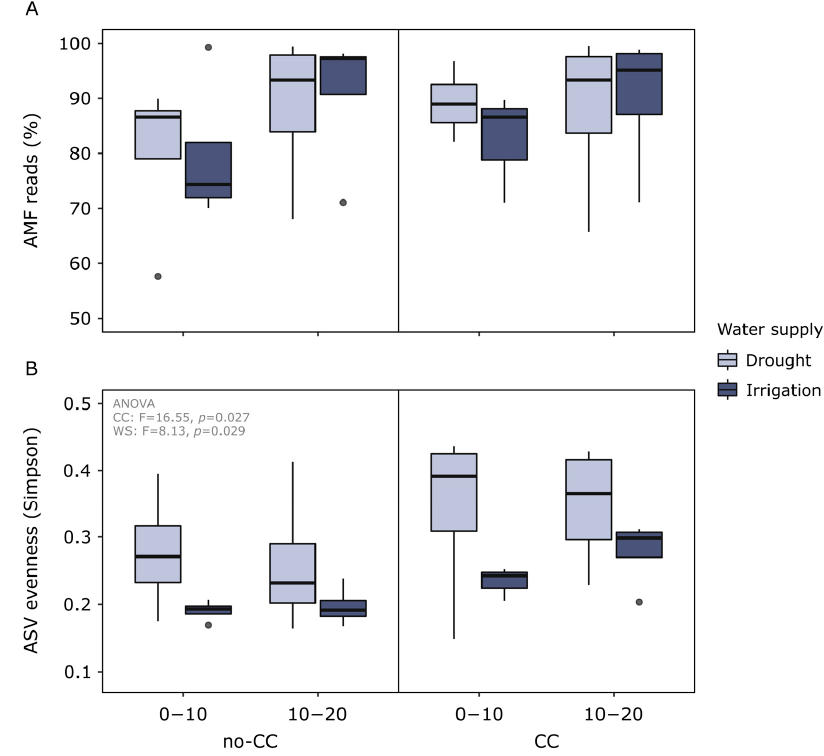
Figure 2. Percentage of arbuscular mycorrhizal fungi (AMF) reads out of the total sequenced reads ( A ) and amplicon sequence variant (ASV) Simpson evenness of soil AMF communities ( B ) in response to cover crops (CC) (no-CC: no cover crop; CC: 4-species cover crop) and water supply (WS) (drought; irrigation). Data are shown for two different soil depths (0–10 and 10–20 cm). Boxplots show median (middle line), 25th and 75th quartiles (hinges), minimum and maximum (whiskers), and outlying points individually. AMF reads were not significantly different between the treatments, whereas AMF ASV evenness was higher in CC than no-CC and higher in drought than irrigation (ANOVA F- and p -values are shown in the plot). Soil AMF evenness (ASV level) was higher in CC than no-CC soils ( p = 0.027) and